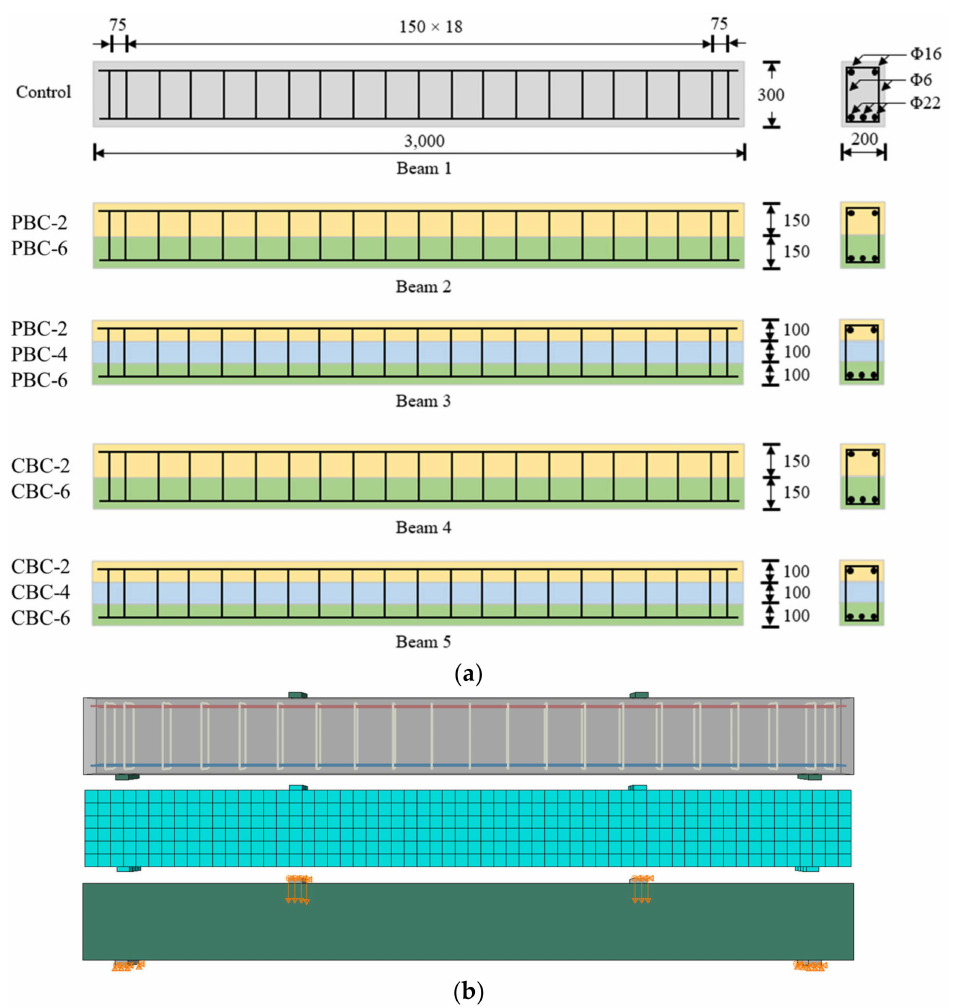
Figure 3. Depiction of the beams: ( a ) design and dimensions (unit: mm); ( b ) finite element model with the meshing, loading, and boundary conditions.